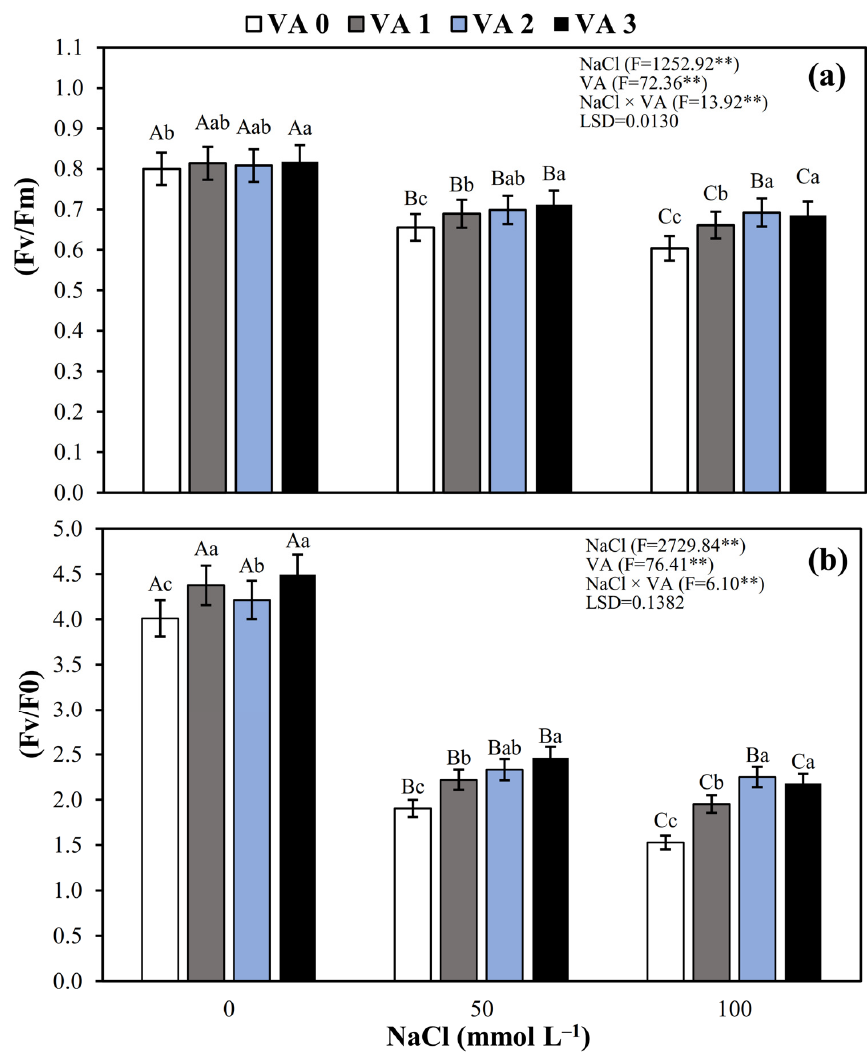
Figure 5. Maximum quantum efficiency of PSII (Fv/Fm) ( a ) and photochemistry efficiency of PSII (Fv/Fo) ( b ) of soybean plants under different levels of salt stress and VA application. Plants were submitted to four concentrations of VA (VA0, non-VA application; VA1, 0.4 mL L − 1 ; VA2, 0.8 mL L − 1 ; and VA3, 1.2 mL L − 1 ) and three levels of NaCl (0, 50, and 100 mmol L − 1 ). Data are mean ± SD (n = 5). Uppercase letters above bars indicate significant differences among NaCl concentrations at the same VA concentration. Lowercase letters above bars indicate differences among VA concentrations at the same NaCl concentration, according to LSD test ( p < 0.05). F values from ANOVA: ** p <